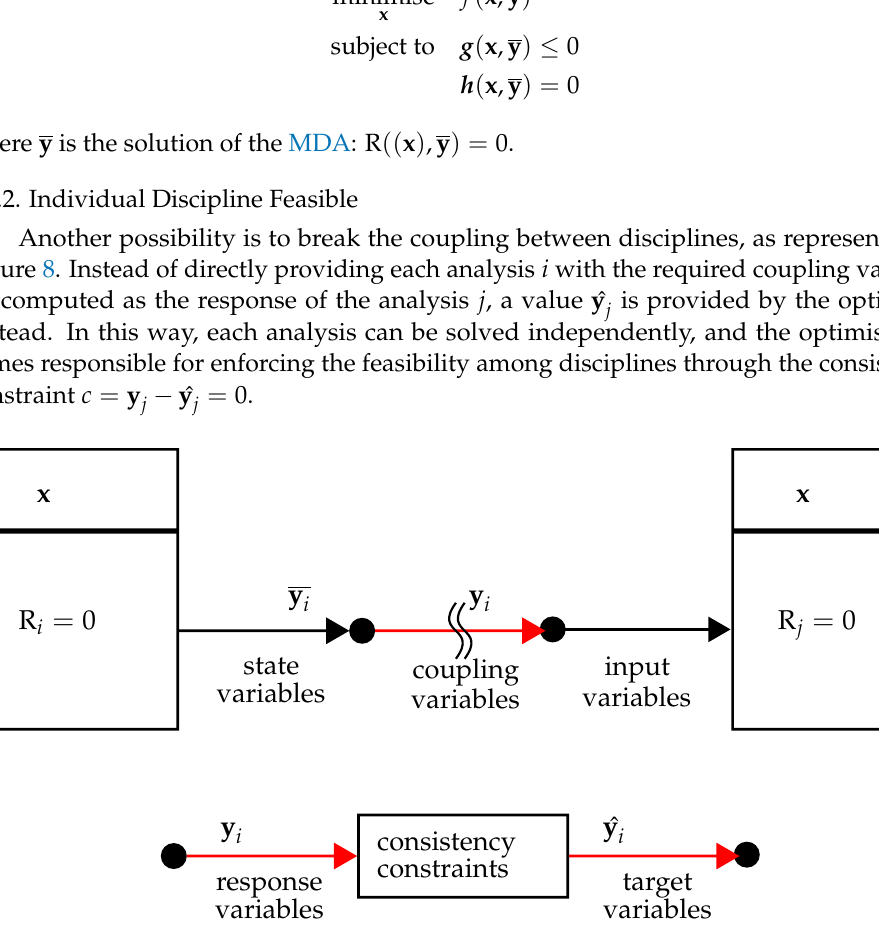
Figure 8. A coupling variable is substituted by a response–target and consistency